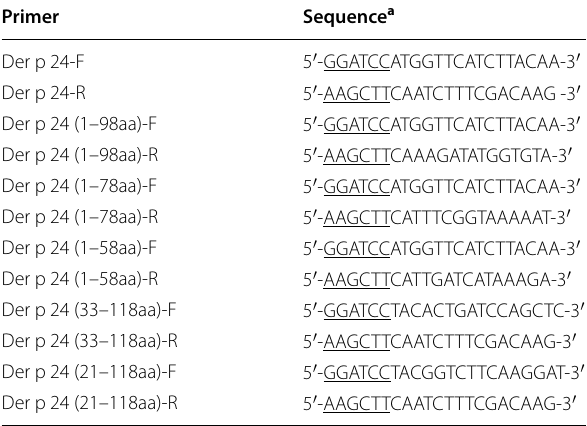
Table 2 Forward (F) and reverse (R) primers used in PCRs and expression